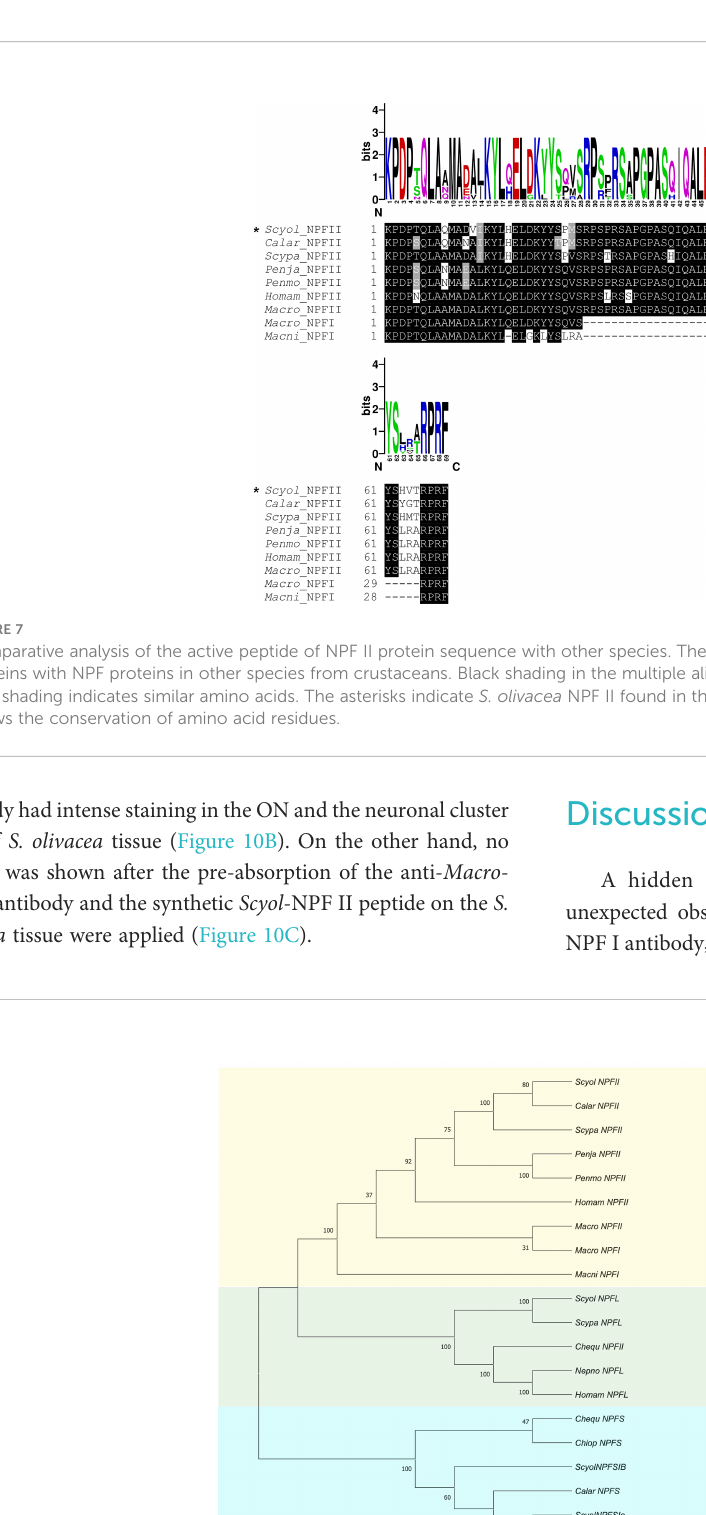
FIGURE 8 Phylogenetic tree analysis of NPF proteins from S. olivacea and other species from crustaceans. The phylogenetic tree was constructed based on the Neighbor-Joining method (number of amino acid substitution model). The number at the nodes represents bootstrap values at an approximate level of percent con fi dence from 1,000 bootstrap replicates. The asterisks indicate S. olivacea NPF II that was found in this